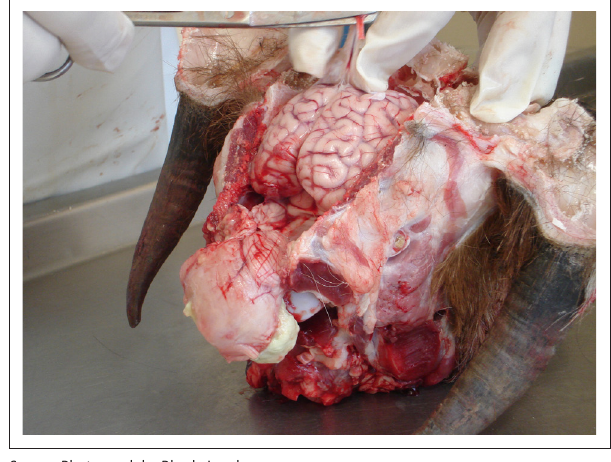
FIGURE 2: Abscess occupying virtually the entire cerebellum.